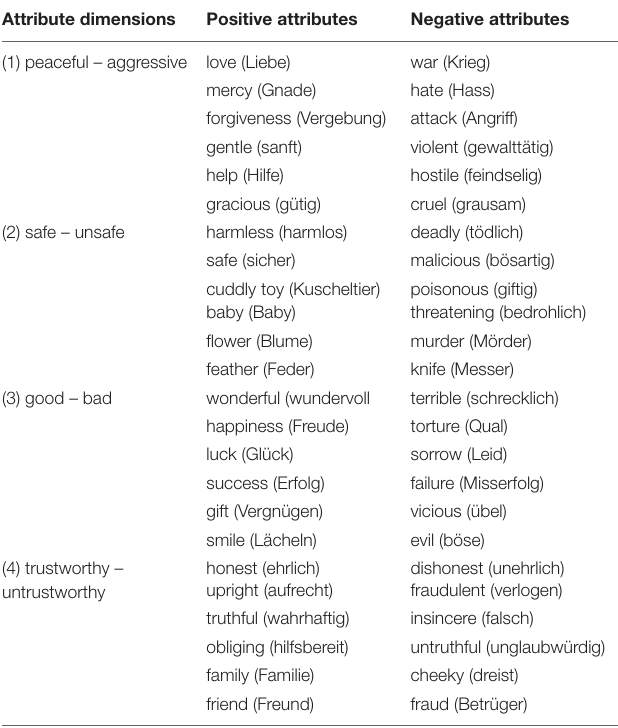
TABLE 1 | Attribute dimensions and attributes used in the md-IAT with original German wording in parentheses (Study 1). Attribute dimensions